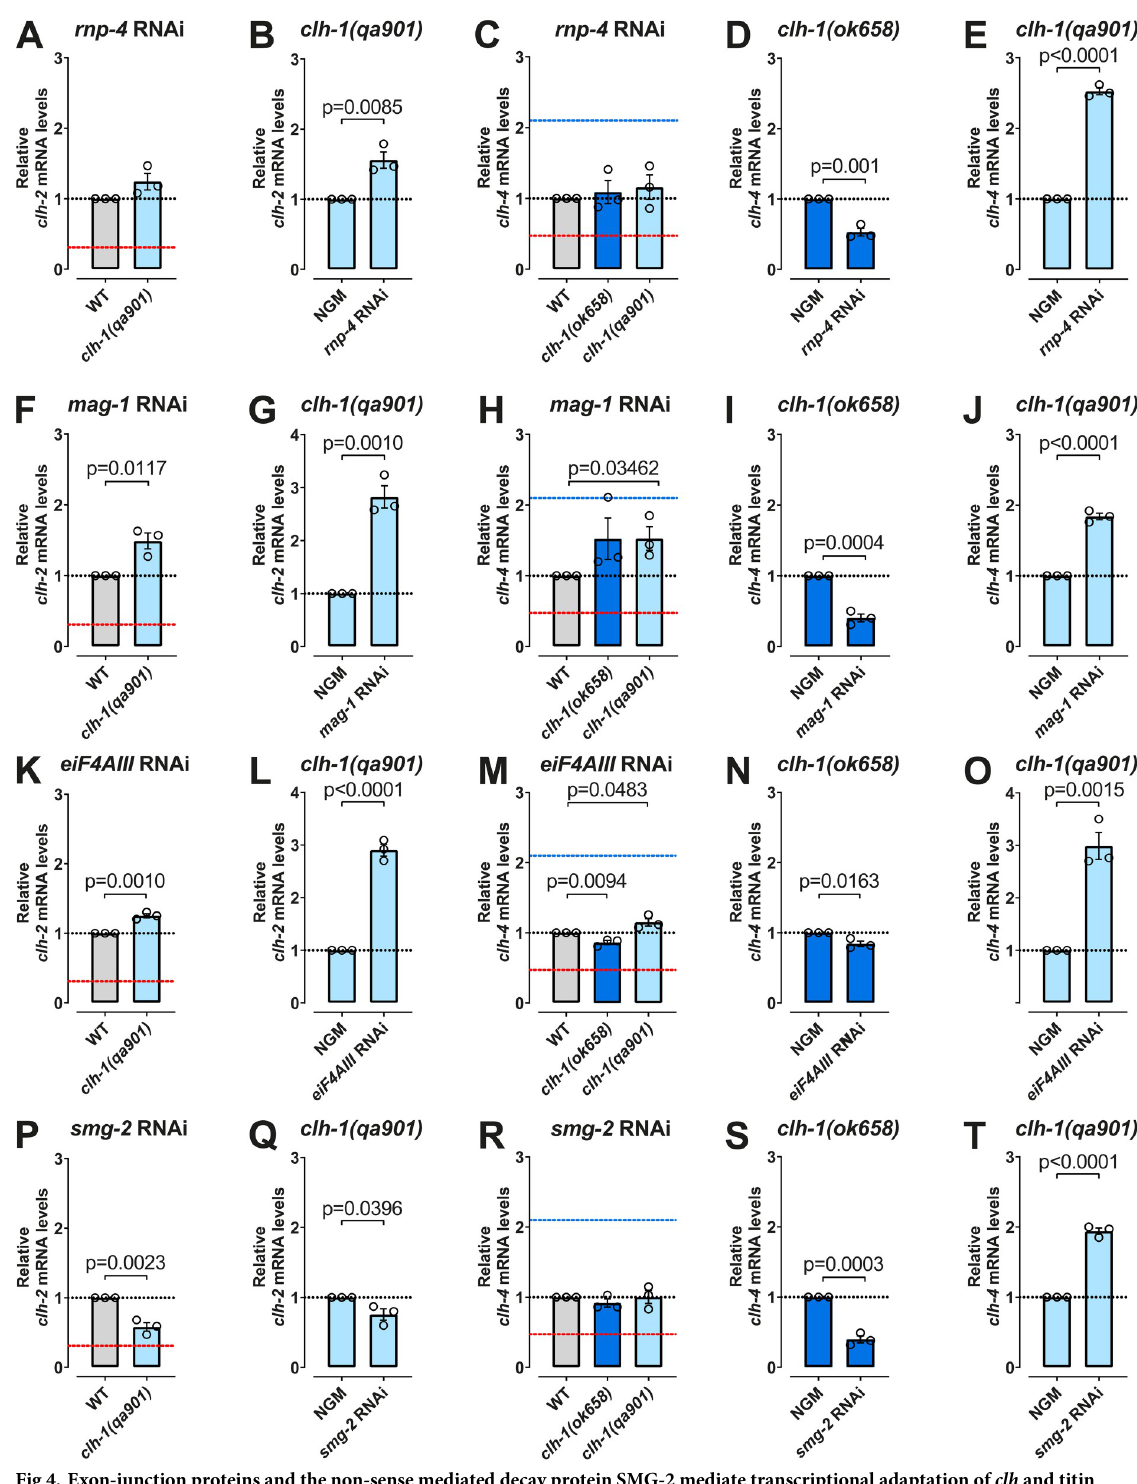
Fig 4. Exon-junction proteins and the non-sense mediated decay protein SMG-2 mediate transcriptional adaptation of clh and titin genes. (A-E) mRNA levels of clh-2 and clh-4 in clh-1 mutant alleles upon knockdown of rnp-4 . (F-J) mRNA levels of clh-2 and clh-4 in clh-1 mutant alleles upon knockdown of mag-1 . (K-O) mRNA levels of clh-2 and clh-4 in clh-1 mutant alleles upon knockdown of eiF4AIII (P-T) mRNA levels of clh-2 and clh-4 in clh-1 mutant alleles upon knockdown of smg-2 . Data are expressed as mean ± SEM and normalized to WT levels or NGM condition, that were taken as 1 (black dotted line). Three independent experiments with three technical replicates